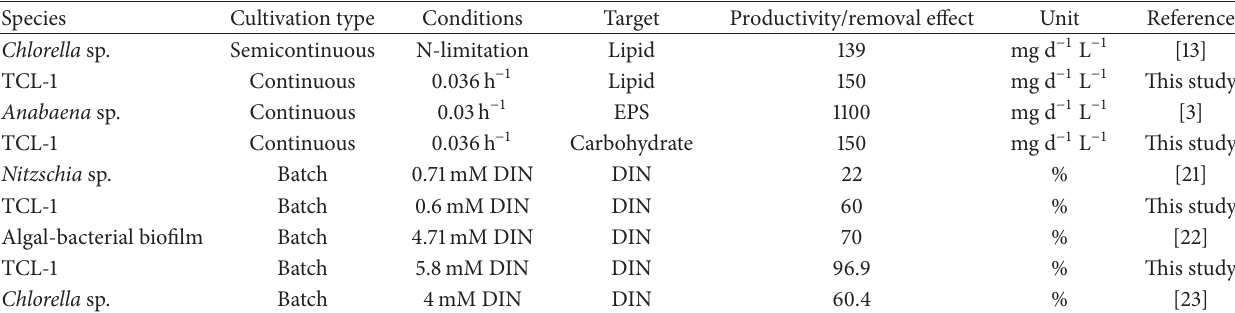
Table 3: The comparison of performance between this study and other